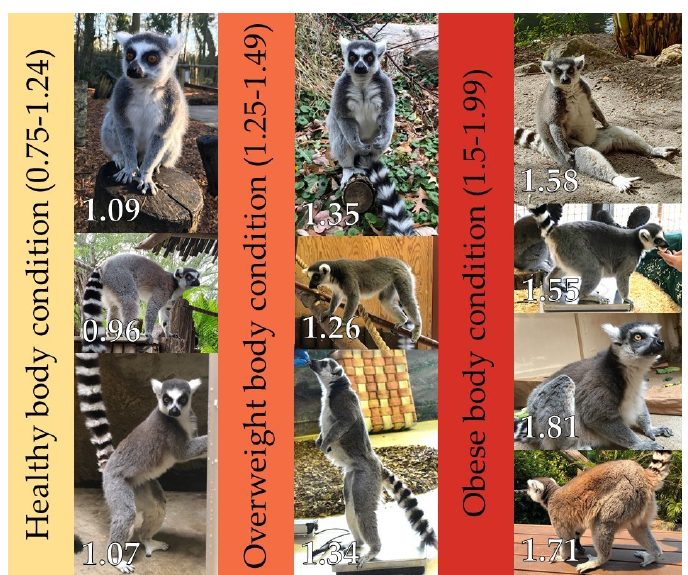
Figure 1. Images of different adult lemurs in one of three body conditions as deemed by their relative body masses: healthy, overweight, or obese. The number at the bottom of each image is that animal’s relative body mass at the time the photograph was taken. Sex of lemurs (credits). Far left , top: female (Lakeland Wildlife Oasis); middle: male (Nancy Nill, Palm Beach Zoo); bottom: female (Ashley Ashcraft). Middle , top: male (Valerie Schultz, Smithsonian’s National Zoo); middle: female ( Ś l ą ski Ogród Zoologiczny); bottom: male (Heidi Beal). Right , top: male (Nancy Nill, Palm Beach Zoo); second from top: female ( Ś l ą ski Ogród Zoologiczny); second from bottom: male (Debbie Fenton); bottom: male (Rebecca Lambert, Taronga Conservation Society).